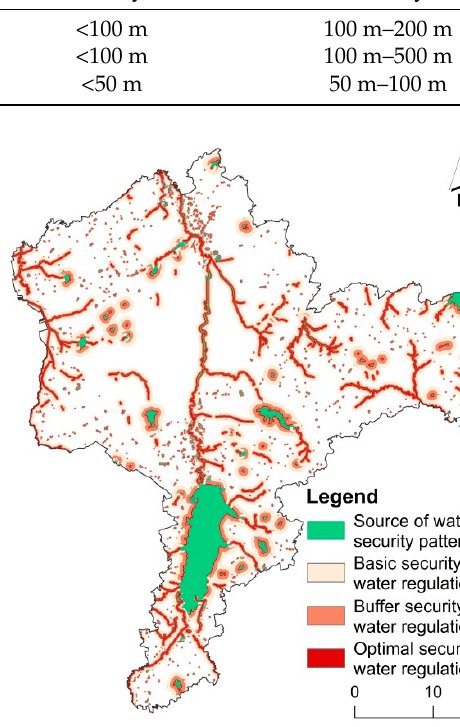
Figure 3. Water regulation security pattern.